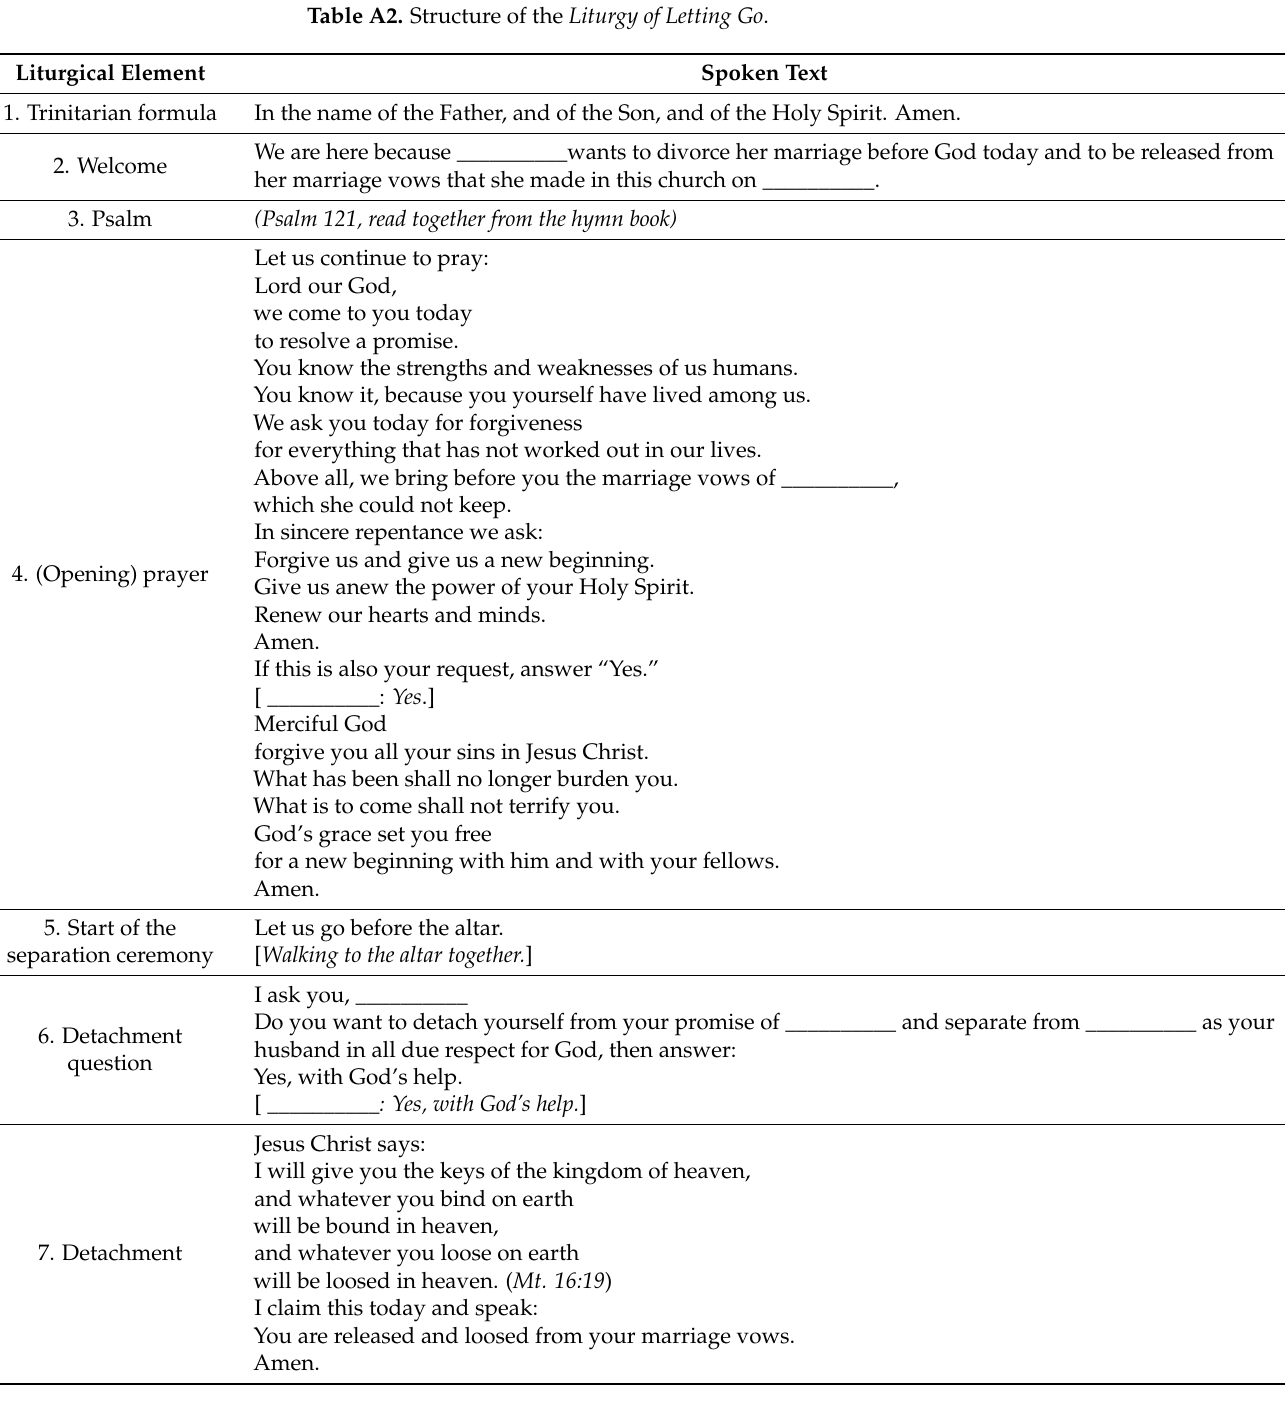
Table A2. Structure of the Liturgy of Letting Go